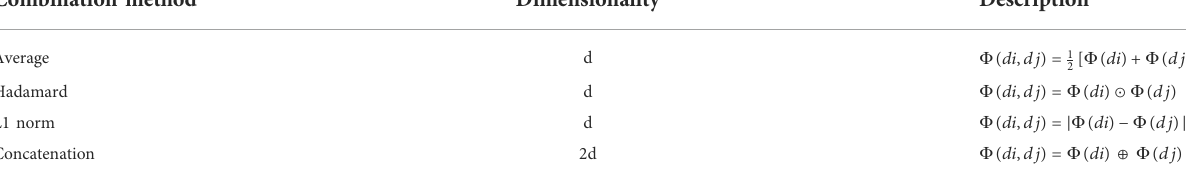
TABLE 2 Four different combinations of drug